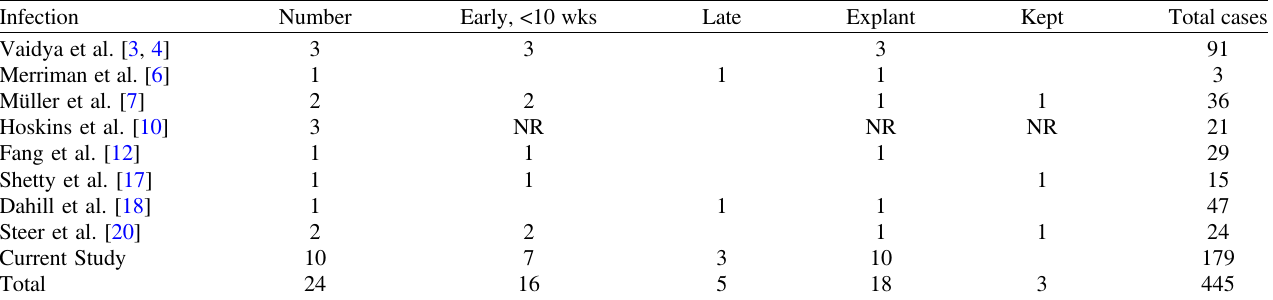
Table 3. In fi x infection literature